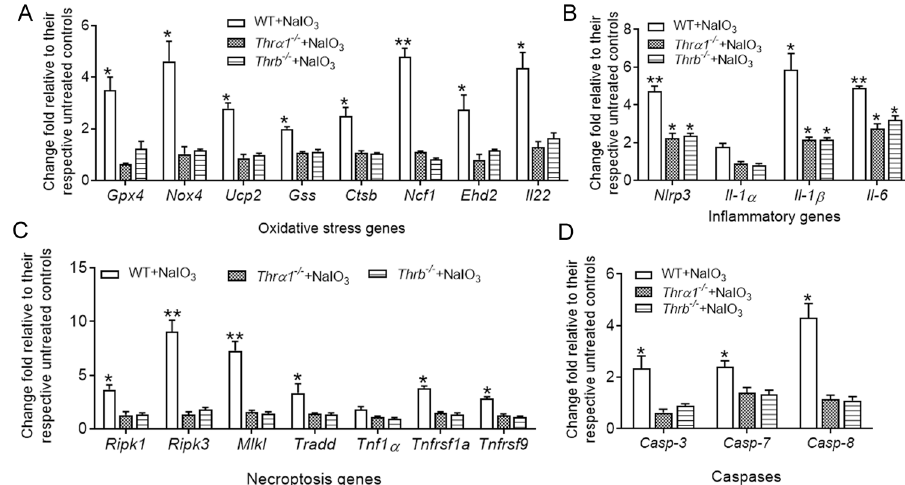
Fig. 7 Deletion of Thr α 1 and Thrb reduced NaIO 3 -induced gene-expression upregulation in the RPE. Expression levels of the genes involved in cellular-stress responses and death signaling in the RPE were examined by qRT-PCR in Thr α 1 − / − , Thrb − / − , and wild-type mice at 1 day post NaIO 3 injection. Shown are expression levels of the genes involved in oxidative-stress responses ( A ), in fl ammatory responses ( B ), necroptosis pathways ( C ), and apoptosis ( D ). Data are represented as means ± SEM for 3 – 4 assays using RPE prepared from 4 to 5 mice per group (* p < 0.05, ** p < 0.01, compared with their respective untreated controls).